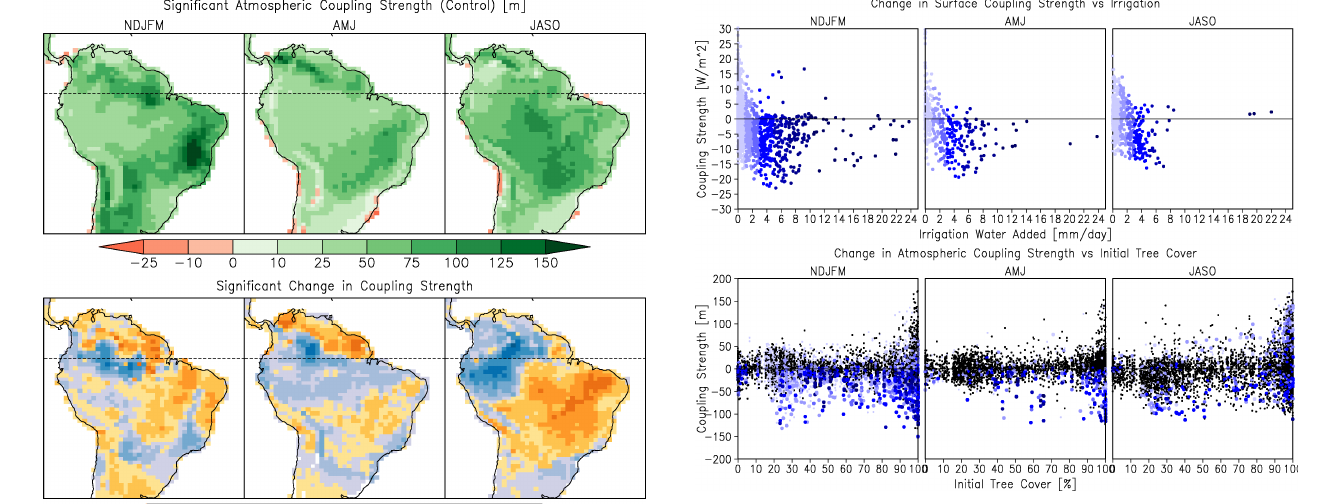
Figure 10. Top row: change in the terrestrial leg of coupling strength (Wm − 2 ) versus irrigation water added (mmday − 1 ) for ir- rigated grid boxes in NDJFM, AMJ and JASO. Bottom row: change in the atmospheric leg of coupling strength (m) versus initial tree cover percentage for NDJFM, AMJ and JASO. Shaded dots repre- sent irrigated grid boxes, with the shading being equivalent to the shading for irrigation water added (mmday − 1 ) in the top